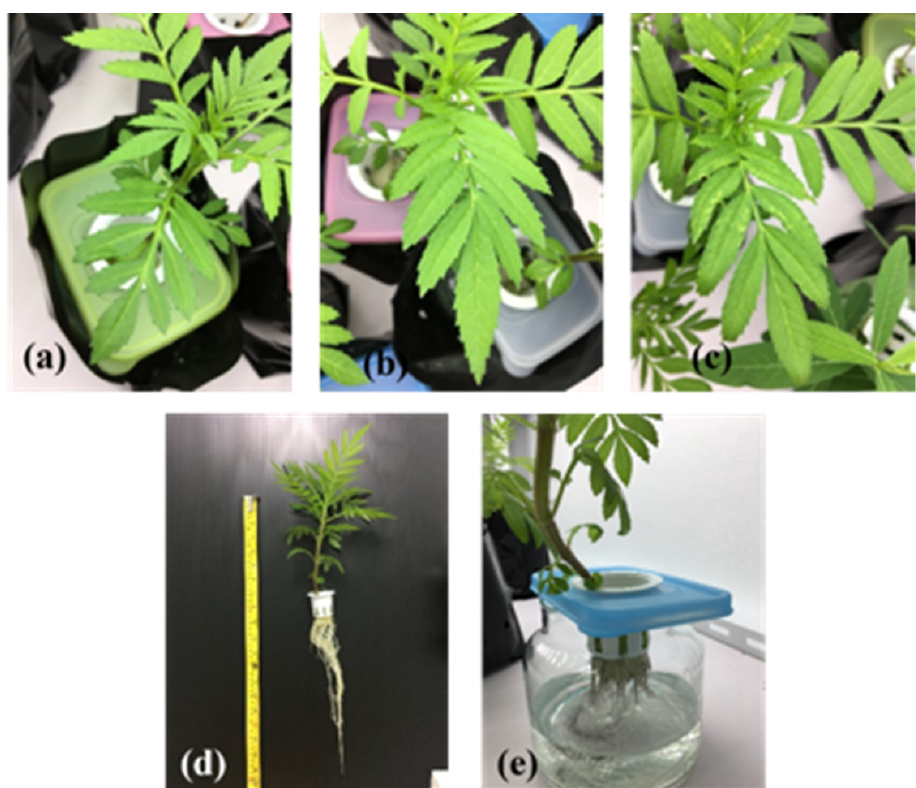
Figure 3. Toxicity in marigold after 4 days of cultivation for carbaryl treatments at 0 mg L − 1 ( a ), 5 mg L − 1 ( b ), and 10 mg L − 1 ( c ), after 12 days of cultivation for carbaryl at 10 mg L − 1 (control) ( d ) and gray roots ( e ).